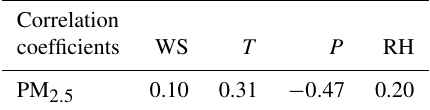
Table 1. Correlation coefficients between hourly PM 2 . 5 concentra- tions and near-surface meteorological elements WS (wind speed), T (air temperature), P (air pressure), and RH (relative humidity) in Wuhan in January